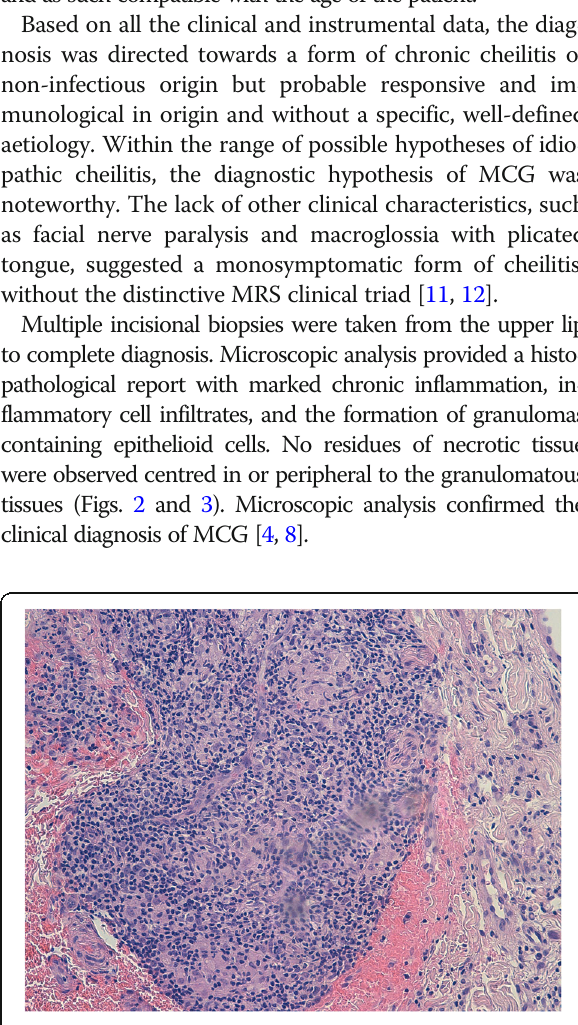
Fig. 2 20× (E&E): Chronic epithelioid granulomatous inflammation without necrosis or confluence